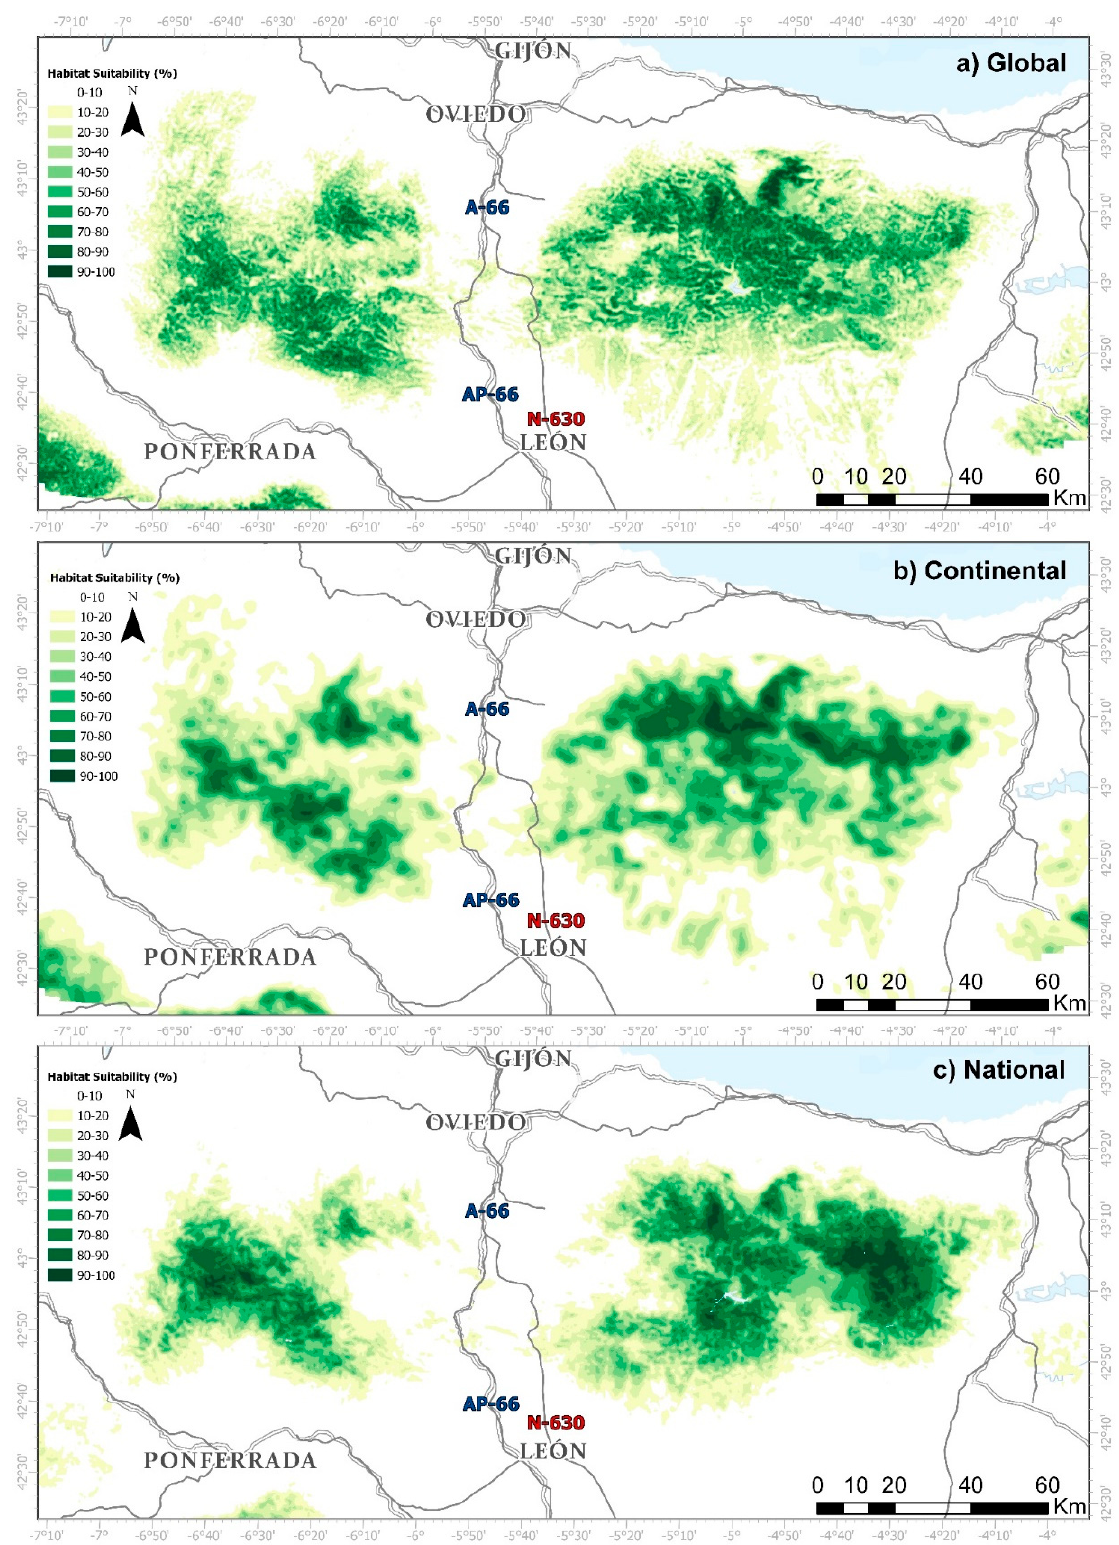
Figure 2. Habitat suitability maps of brown bear obtained from multivariate models for each dataset: ( a ) global dataset (from Sentinel-1 and Sentinel-2 imagery), ( b ) continental dataset (from CORINE Land Cover 2018 map in combination with Forest Type high-resolution layer of CLMS), and ( c ) national dataset (Spanish Forest Map in combination with Li-DAR).